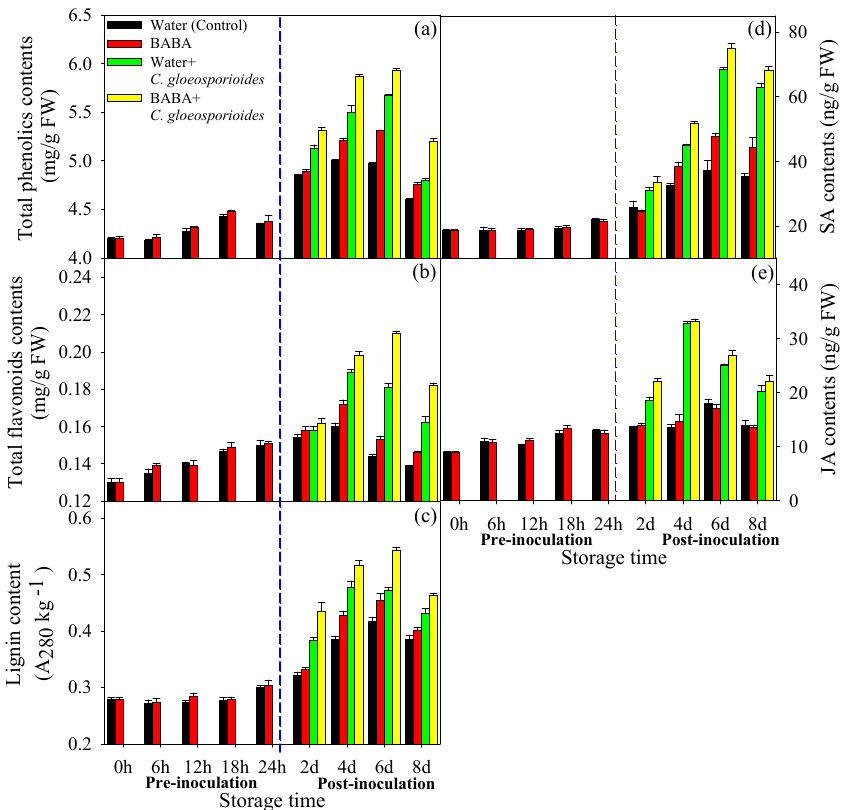
Figure 2. Effect of BABA treatment on total phenolics ( a ), total flavonoids ( b ), lignin content ( c ), SA ( d ), and JA ( e ) content in mango fruit. Data presented are means ± standard errors (n = 3).